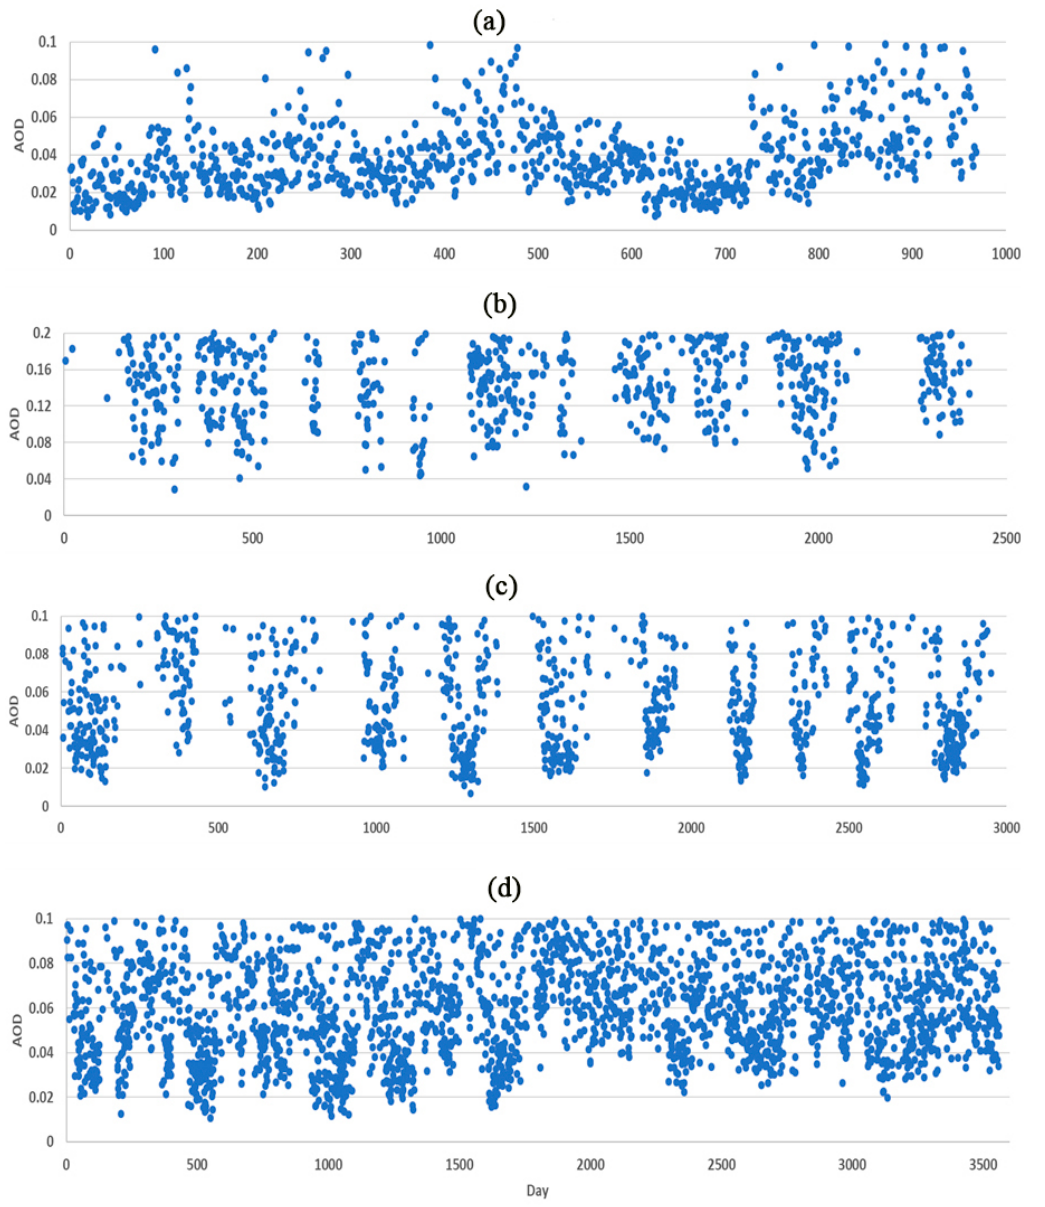
Figure 3. The AOD variations in multiple years based on the ground measurements from four different AERONET sites around the world ( a ) Fowlers_Gap, ( b ) Mezaira, ( c ) Tamanrasset_INM, and ( d ) Dalanzadgad.